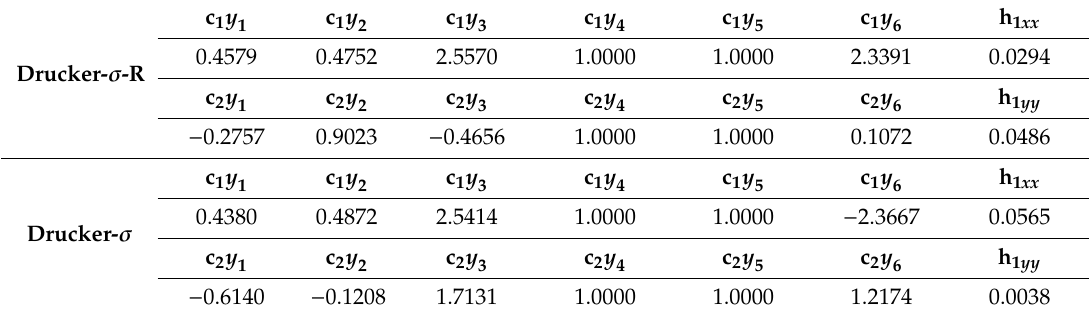
Table 13. Parameters of the extended Drucker yield functions for Zirconium.